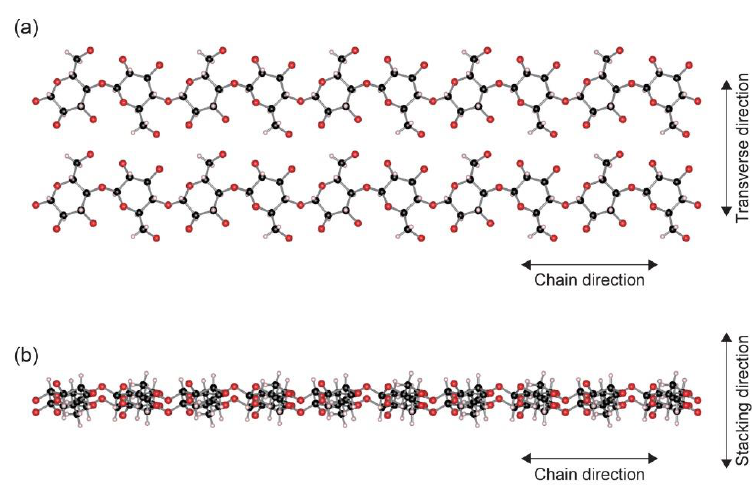
Figure 2. Cellulose I β structure viewed along [001] ( a ) and [010] ( b ) directions. The schemas were produced based on the crystallographic parameters given in Nishiyama et al. [45], utilizing a visualization program VESTA 3 [52]. Carbon, oxygen and hydrogen atoms are colored black, red and white, respectively.